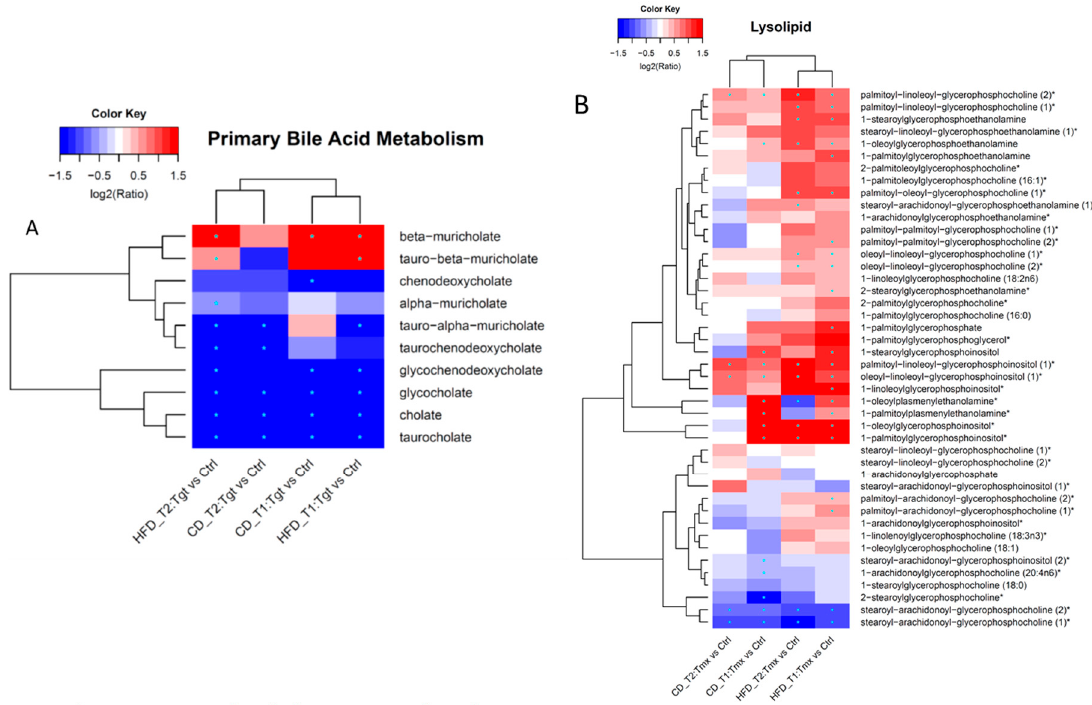
Figure 7. Hierarchical clustering analysis heatmaps of fold changes on the log2 scales. ( A ) metabolites in sub pathway primary bile acid metabolism related to Tgt treatment; ( B ) metabolites in sub pathway lysolipid related to Tmx treatment. * indicates p value < 0.05, FDR < 0.2, and fold change ≥ 1.2. Diets: standard diet (CD); high fat diet (HFD); Times: T1, 78 days of age; T2, 190 days of age; Treatments: Ctrl, control; Tgt, targretin; Tmx, tamoxifen.